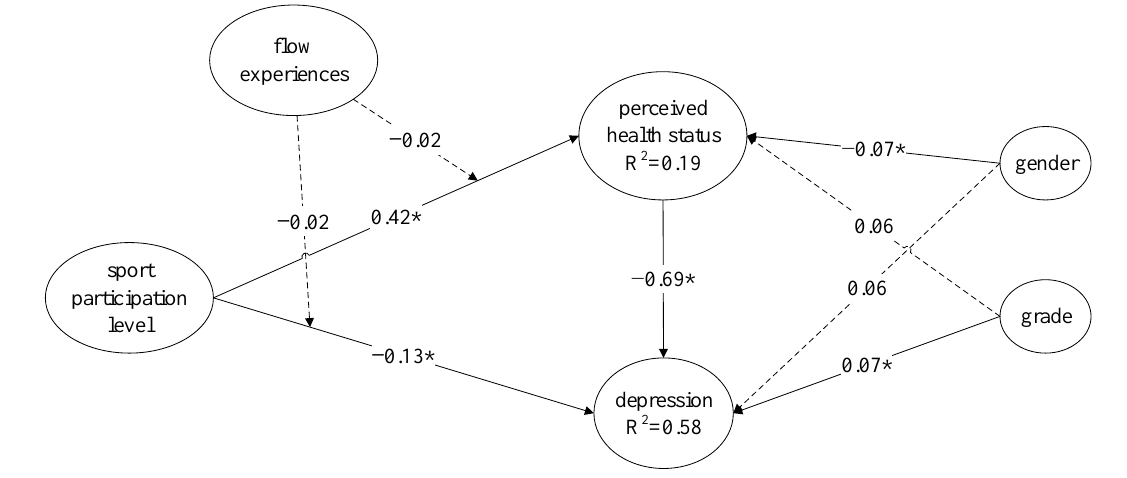
Figure 2. SEM results of the standardized model parameter estimation. Note: “...” represents “path coefficient was not significant” “–” represent s “path coefficient was significant”. * p < 0.05.